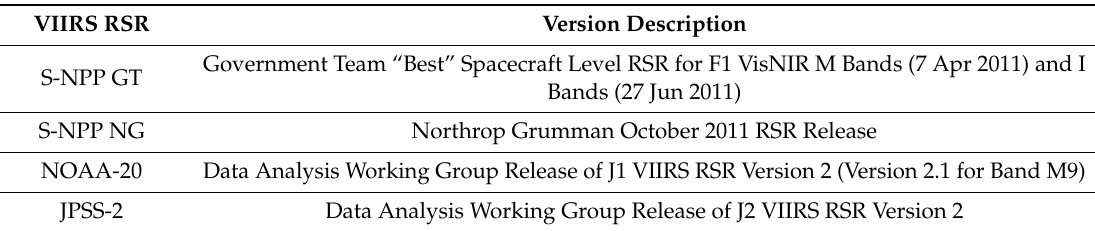
Table 2. Version descriptions of the VIIRS relative spectral response (RSR) products used in this